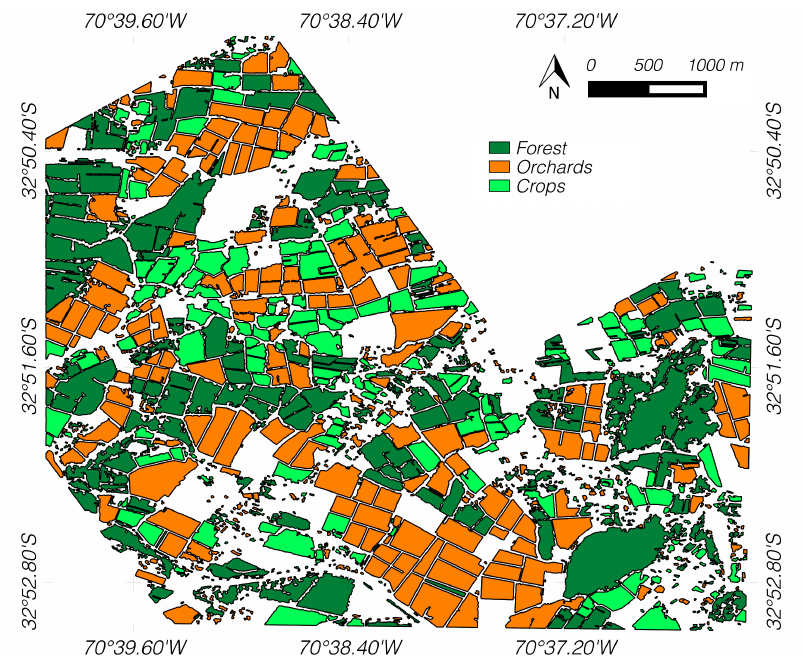
Figure 7. Map of the vegetated areas. Two types of parcels are distinguished among them and from other vegetated areas using shape and texture characteristics.